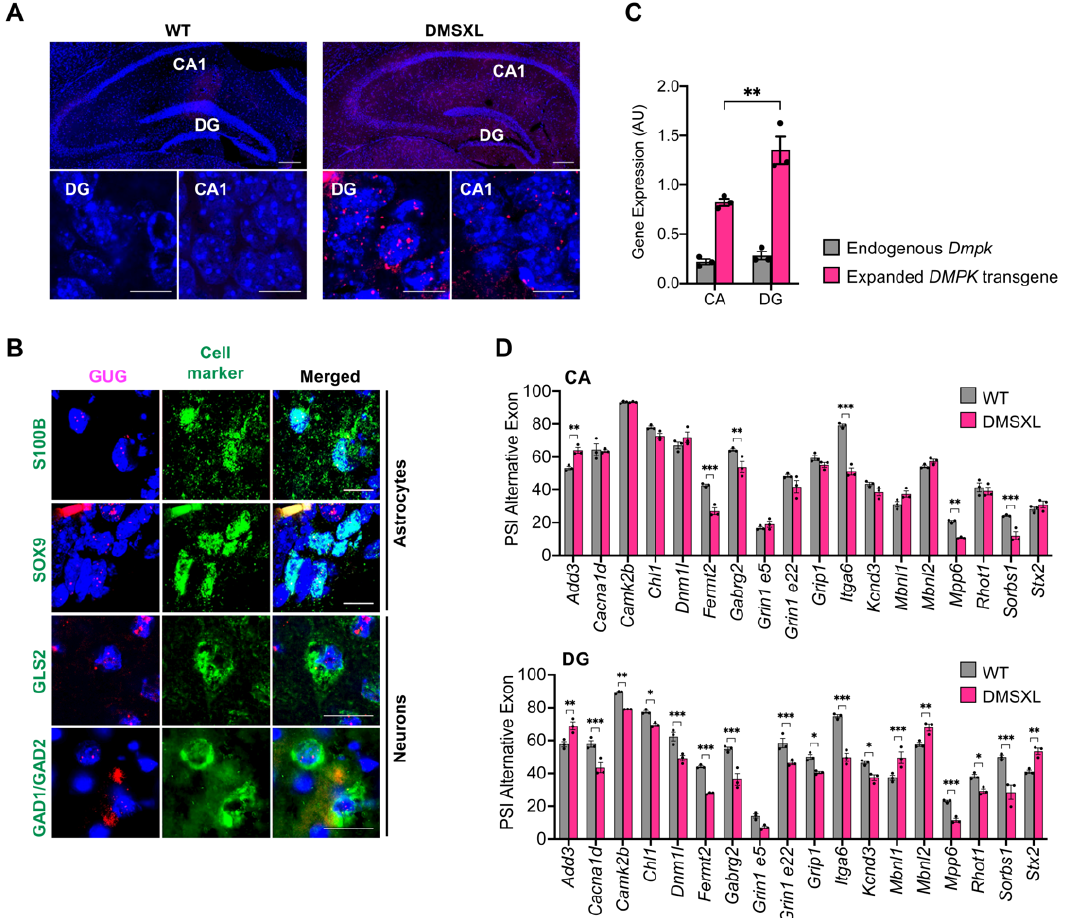
Figure 7. RNA foci accumulation and spliceopathy in the DMSXL hippocampus. ( A ) FISH analysis of nuclear foci accumulation in the hippocampus of WT and DMSXL mice. The DMSXL hippocampus shows greater foci content in DG compared with CA1 at 1 month of age. Scale bar a lower magnifica- tion, 200 µ m. Scale bar a higher magnification, 50 µ M. ( B ) FISH of RNA foci (magenta) combined with IF detection of astrocyte (S100B or SOX9), glutamatergic (GLS2), and GABAergic (GAD1/GAD2) protein markers (green). Nuclei were stained with DAPI (blue). Scale bar, 10 µ m. ( C ) Expression of human DMPK transgene and mouse endogenous Dmpk gene relative to Polr2a internal control in CA and DG areas of the DMSXL hippocampus at 1 month of age. ** p = 0.0022. ( D ) Splicing dysregulation in the CA and DG areas of the DMSXL hippocampus at 1 month of age ( n = 3 mice per genotype). The graphs represent the PSI (percentage of splicing inclusion) of alternative exons. * p < 0.05, ** p < 0.001, *** p < 0.001 (two-way ANOVA, Sidak post hoc test for multiple